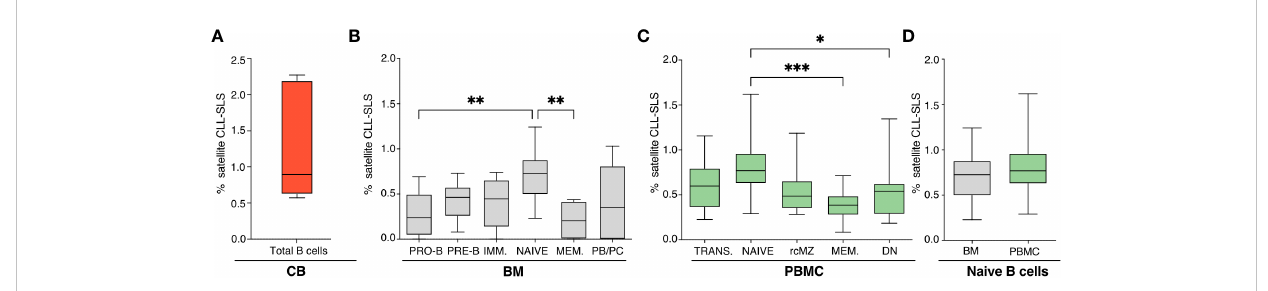
FIGURE 2 (A-C) Frequencies of CLL-SLS resembling satellite stereotyped CLL BCRs identi fi ed in: (A) CB B cells (n=5); (B) BM B cell subsets (n=11); and (C) PBMC B cell populations (n=16). Statistical analyses were calculated with Kruskal-Wallis test. (D) Comparison of CLL-SLS frequencies in naïve B cells from BM and PBMC. Bars display minimum and maximum values. * p ≤ 0.05, **p ≤ 0.01, ***p ≤ 0.001